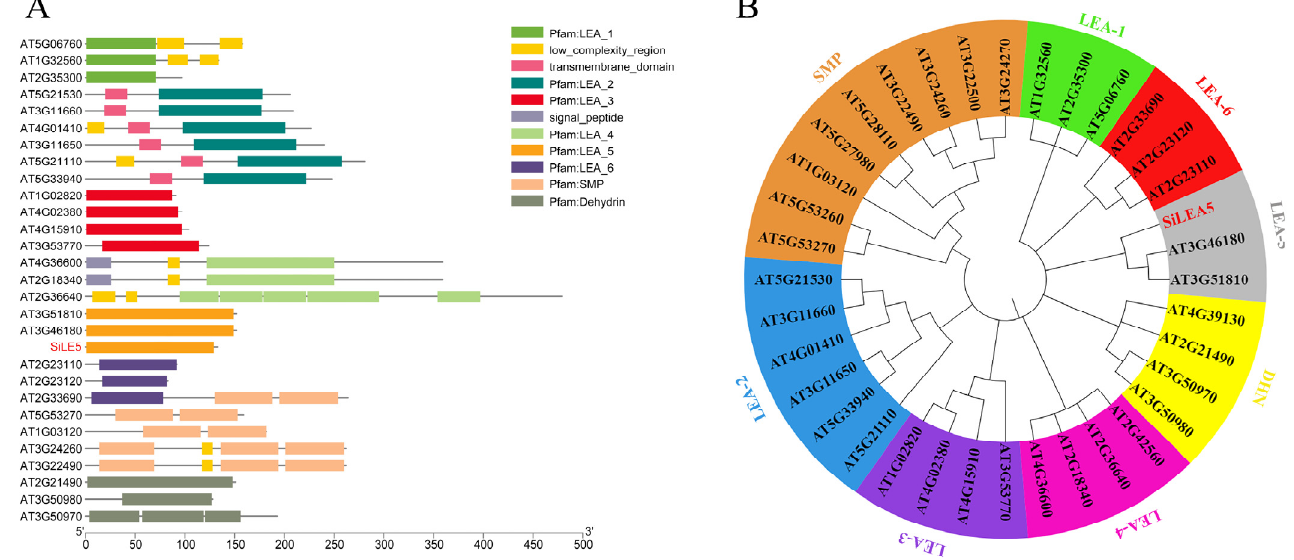
Figure 1. Conserved domain and phylogenetic analysis of SiLEA5 protein. ( A ) Conserved domain analysis of SiLEA5 protein. The Arabidopsis LEA protein and SiLEA5 protein were annotated using the Pfam database about conserved structural domains. The visual structure map of conserved structural domains was constructed using TBtools. The different colored squares represent the conserved